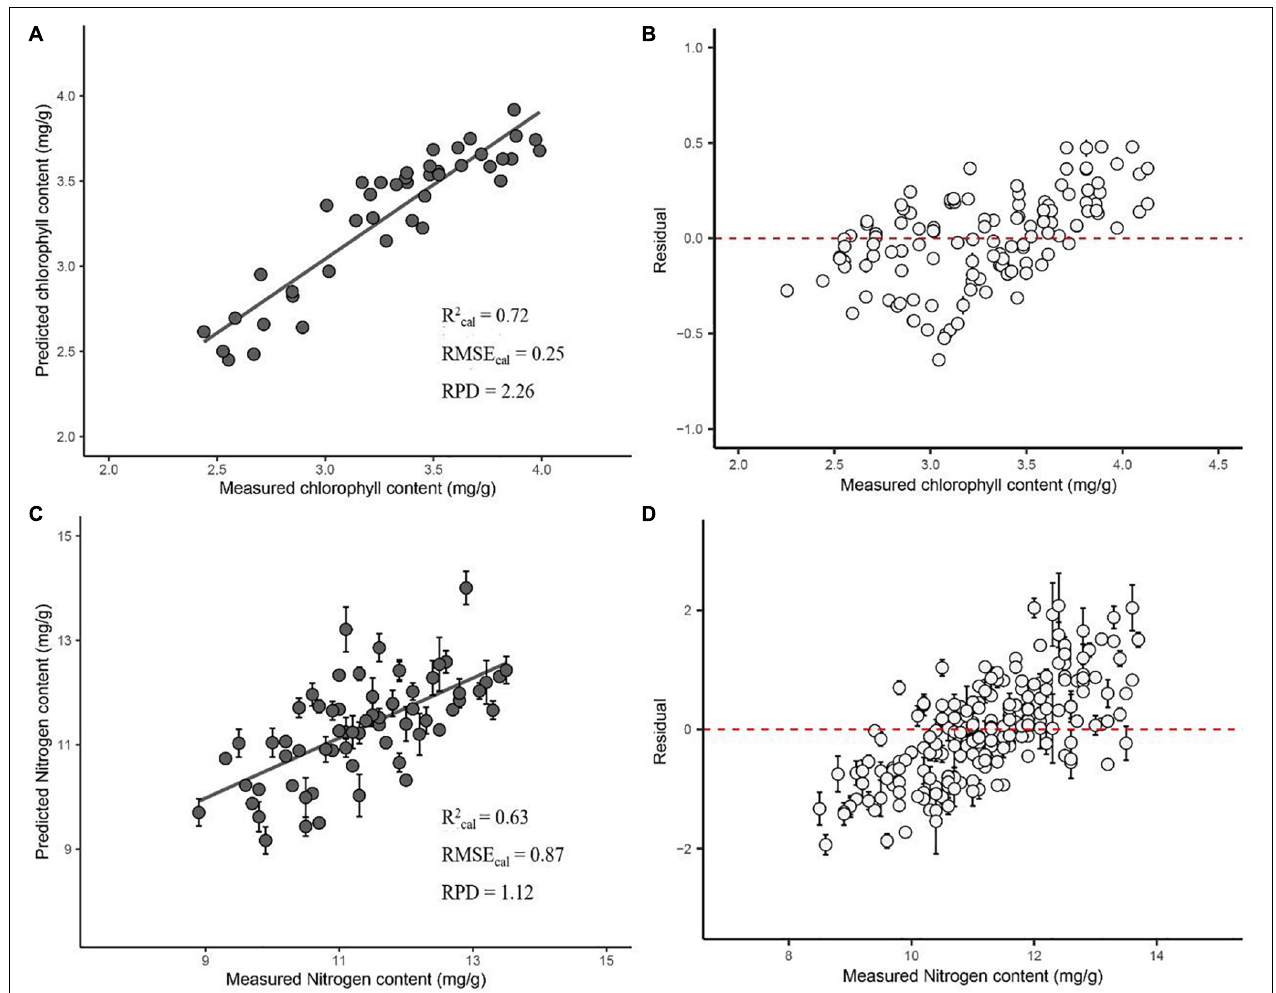
FIGURE 3 | Optimal PLS model of the chlorophyll content based on SNV_SSG combined with the Ga variable selection method (A) and the nitrogen content based on FSG combined with the sMC variable selection method (C) . Residuals plotted of chlorophyll content (B) and nitrogen content (D)